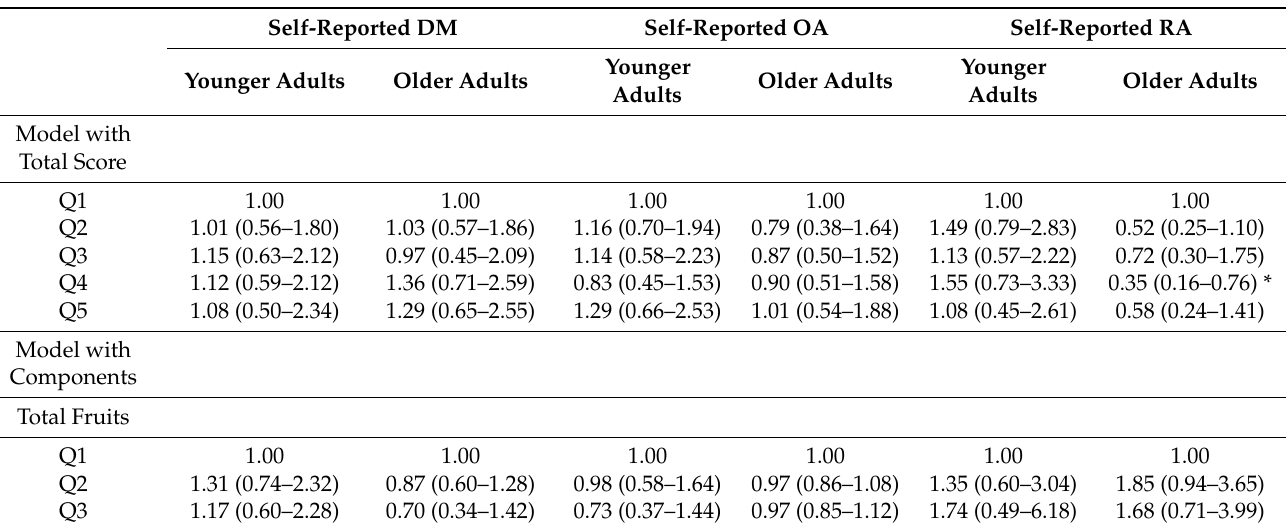
Table 5. Odds ratios and 99% confidence intervals of self-reported diabetes mellitus, osteoarthritis, and rheumatoid arthritis among younger and older US adults from the initial Models with the Healthy Eating Index-2015 total and component scores: NHANES